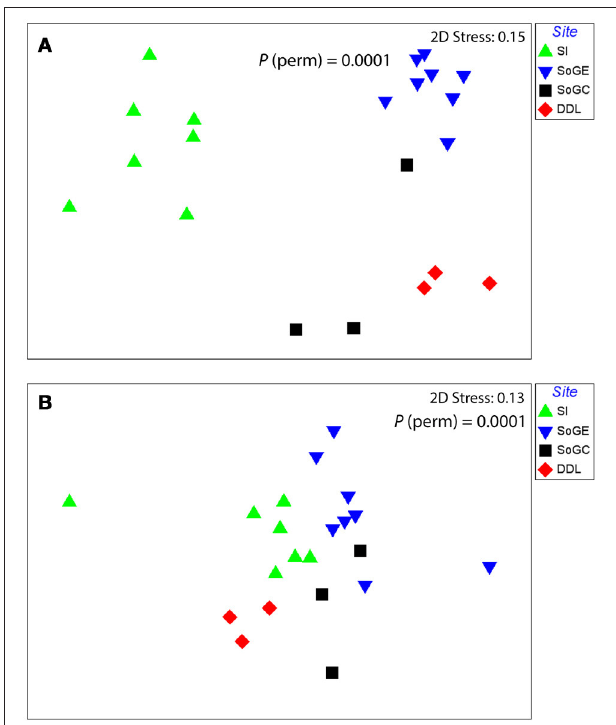
FIGURE 2 | Non-metric multi-dimensional scaling (nMDS) plot of (A) benthic community taxonomic assemblages at each study site based on Bray-Curtis similarity matrices performed on fourth root transformed data, and (B) benthic fluxes at each study site based on Euclidean similarity matrices performed on normalized